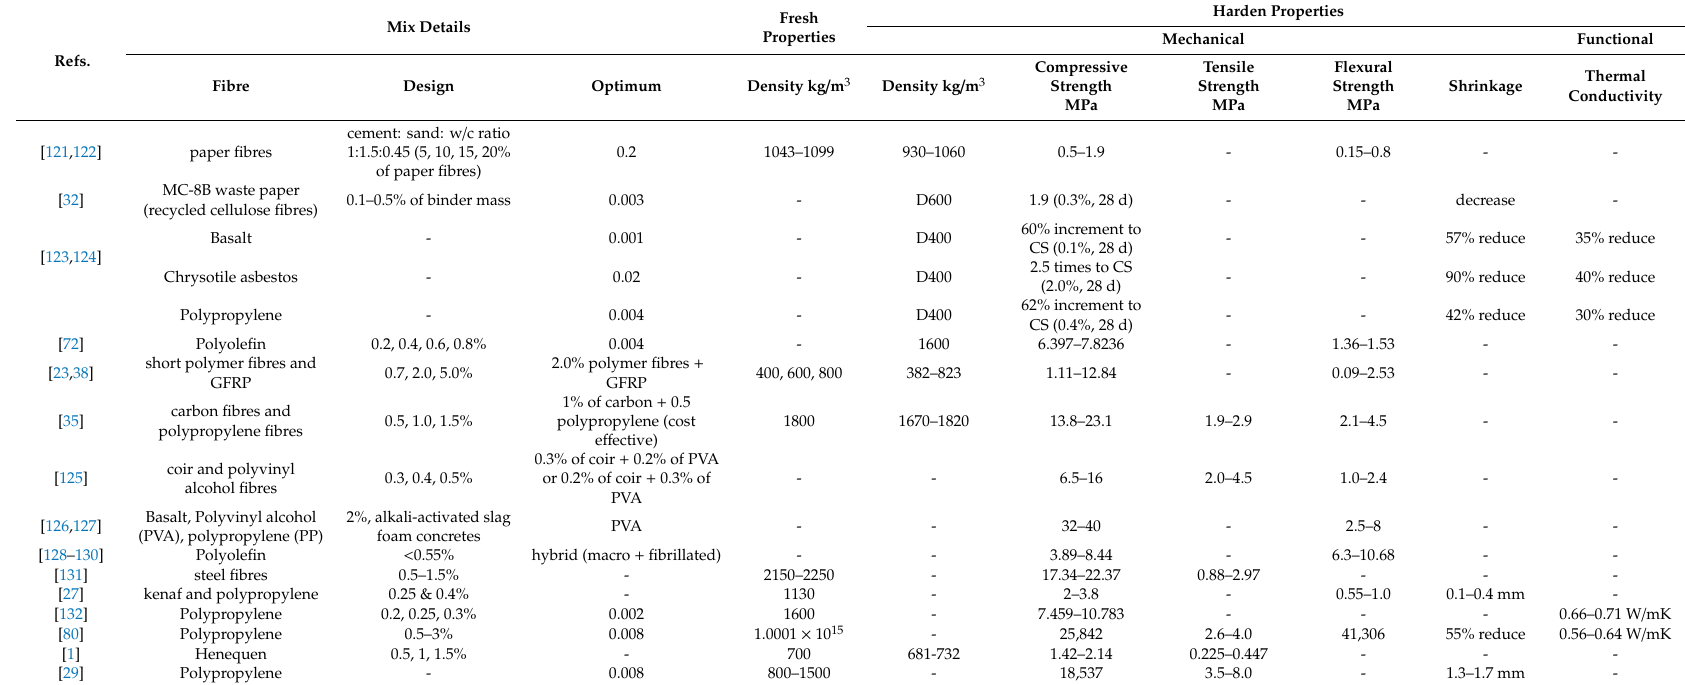
Table 6. Properties of di ff erent FRFC composites and